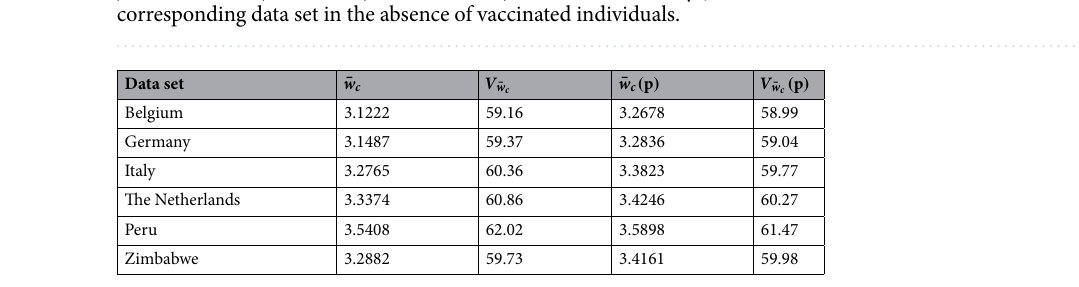
Table 1. Mean vaccination coverage (in %) given by (4) adopting the uniformly random vaccination strategy at the critical per capita vaccination rate with a 100% vaccine efficacy, ¯ w c (in %), and with probabilities p = ( 1, 0.95, 0.9 ) of being successful, ¯ w c ( p ) (in %). Parameters: γ 1 = 1 , γ 2 = 1 , γ 3 = 0.9 , δ v 1 = 1 / 40 , δ v 2 = 1 / 52 , δ v 3 = 1 / 40 . For each country, β is scaled such that R 0 = 2.5 without vaccination.